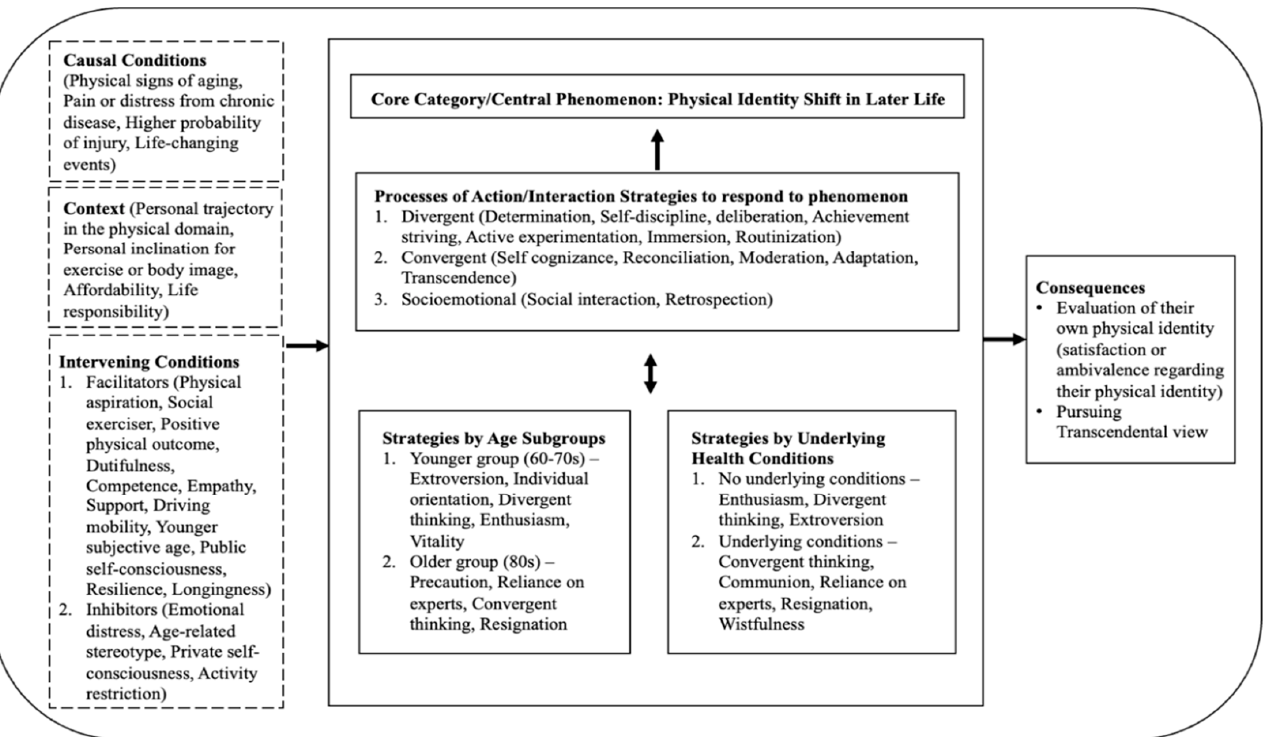
Figure 1. Model of physical identity development in later life.